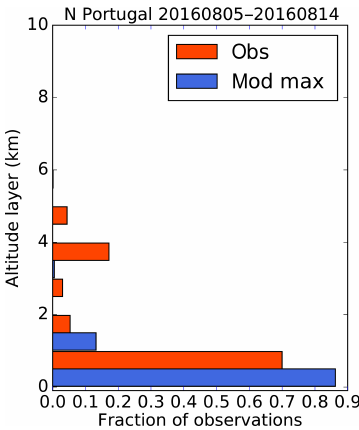
Figure 8. Distribution of the aerosol plume heights (1km vertical layers) observed by MISR (obs) and simulated by CHIMERE at the same location and time